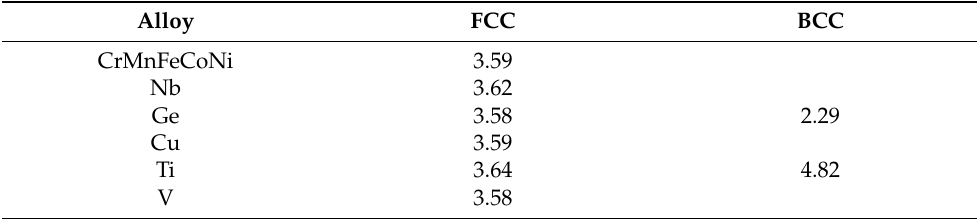
Table A2. Lattice parameters (in Å) from XRD measurements of FCC and BCC phases, based on results report in